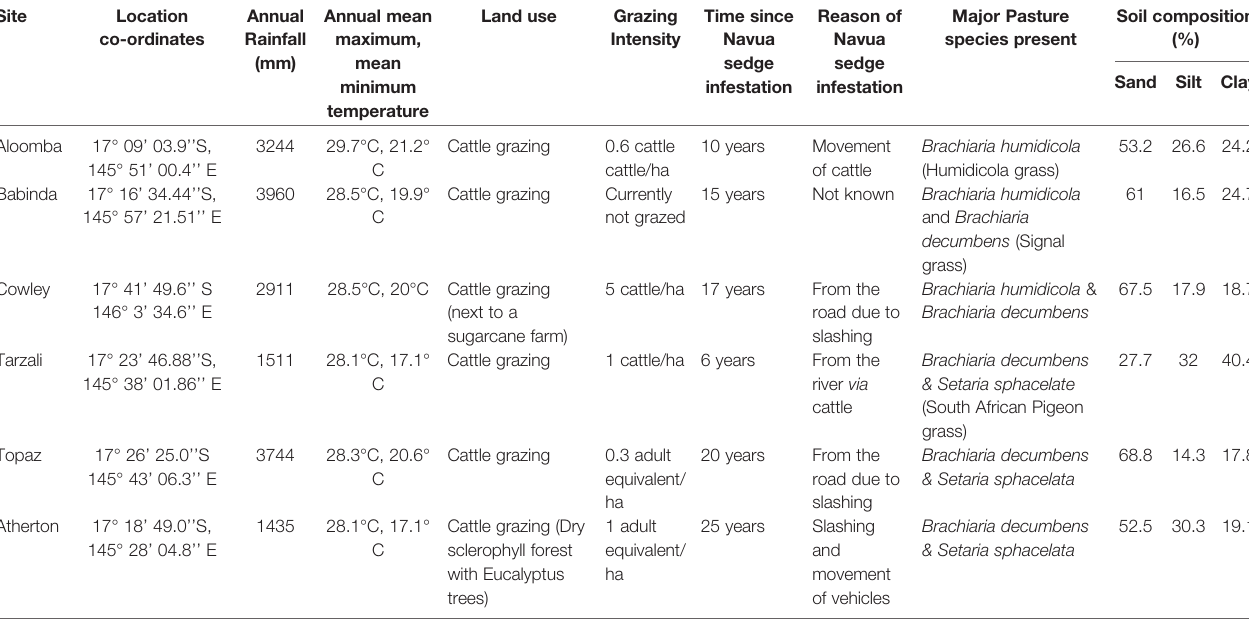
TABLE 1 | Description of the study sites at Aloomba, Babinda, Cowley, Tarzali, Topaz and Atherton in far north Queensland.